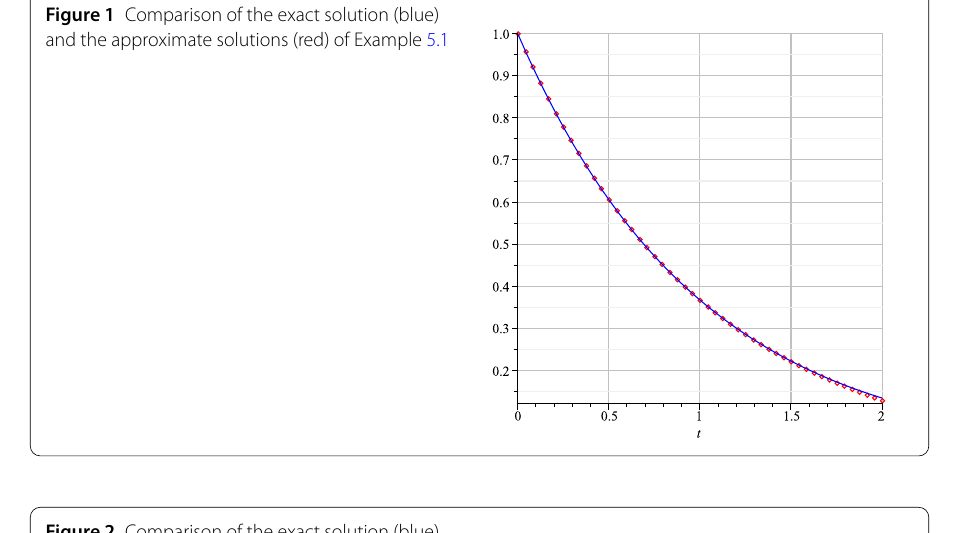
Figure 2 Comparison of the exact solution (blue) and the approximate solutions (red) of Example 5.2